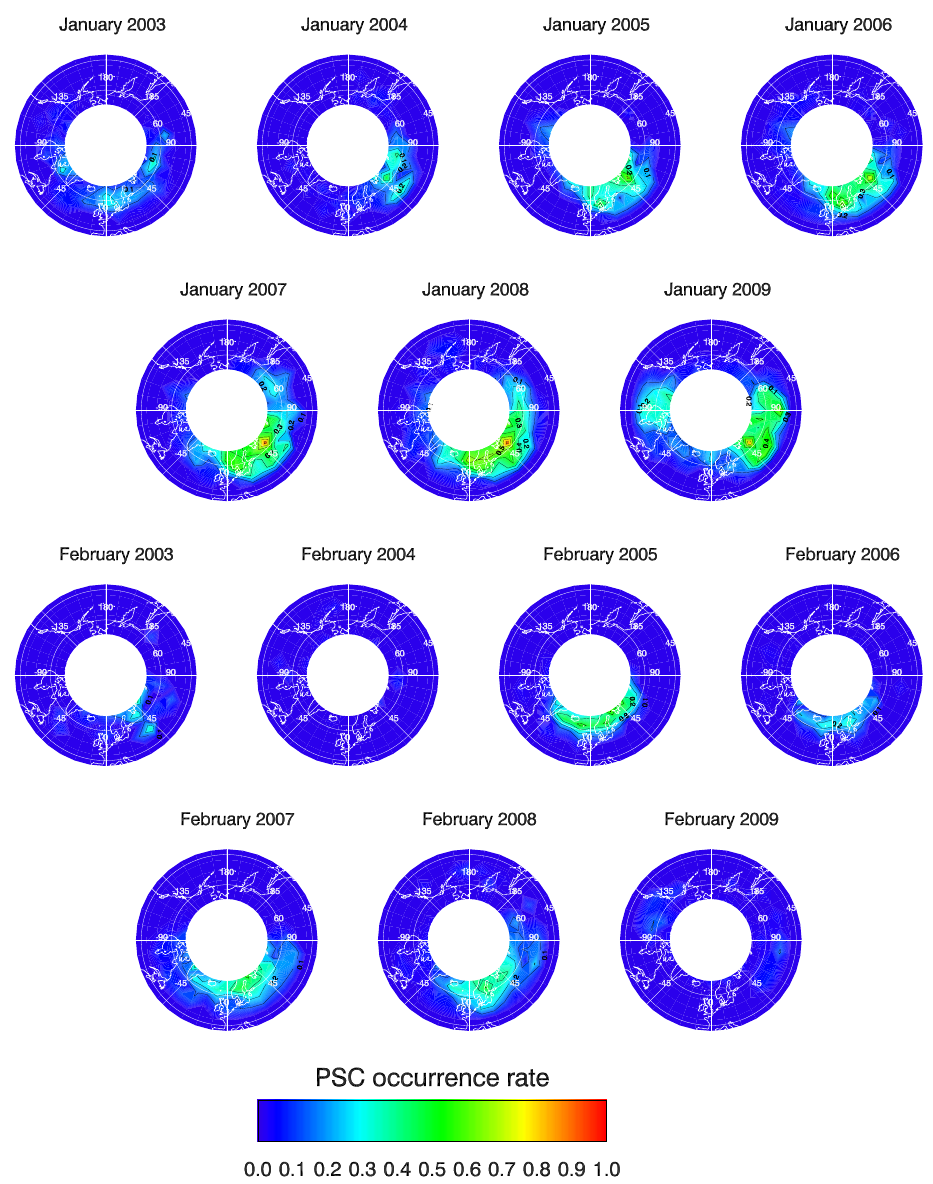
Fig. 6. Maps of PSC occurrence rates in the northern polar atmosphere for January and February of the years 2003–2009. Contour levels are drawn in steps of 0.1. Meridians are displayed in steps of 45 ◦ and latitude circles are shown for 45 ◦ N and 60 ◦ N.